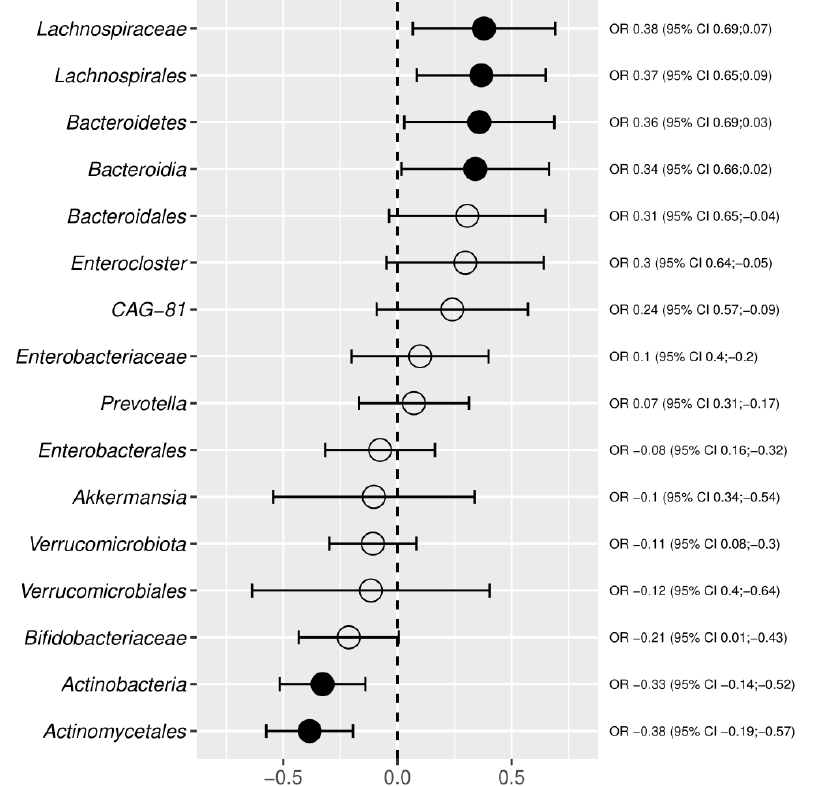
Figure 6. The results of random-effects meta-analysis for effect sizes based on the mean differences in centered log ratios. The left side of the graph describes bacteria with increased relative abundance in CAD, and the right side of the chart represents bacteria with decreased relative abundance in CAD. The filled dot denotes a statistically significant result of the random-effects meta-analysis.